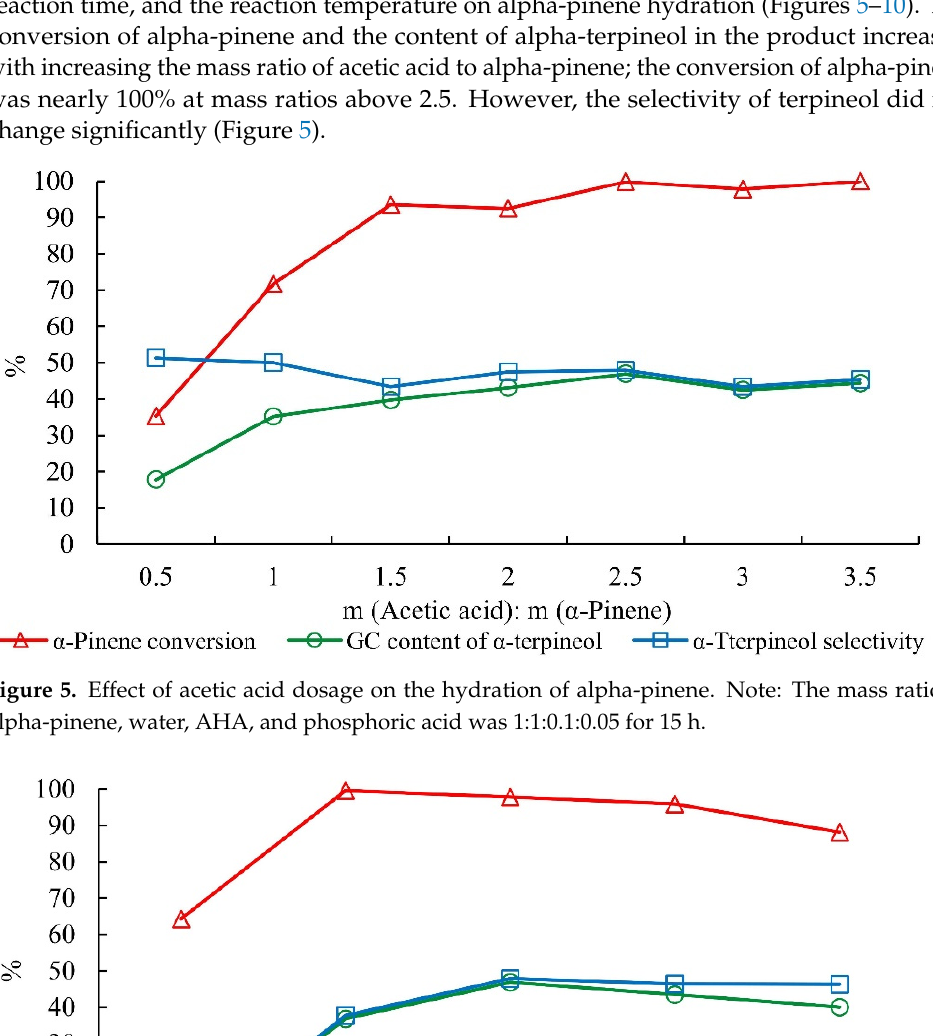
Figure 7. Influence of citric acid dosage on the hydration of alpha-pinene. Note: The mass ratio of alpha-pinene, water, acetic acid, and phosphoric acid was 1:1:2.5:0.05 for 5 h. Under experimental conditions, the conversion of alpha-pinene increased with an increase in phosphoric acid, although the increase was insignificant when the mass ratio of phosphoric acid to alpha-pinene was greater than 0.5 (Figure 8). The content and selec- tivity of alpha-terpineol increased and then decreased with phosphoric acid concentra- tion. It reached a maximum with a phosphoric acid/alpha-pinene mass ratio of 0.5. Excess phosphoric acid promoted the isomerization of alpha-pinene to limonene and terpinolene, which led to a decrease in the alpha-terpineol content and product selectivity.